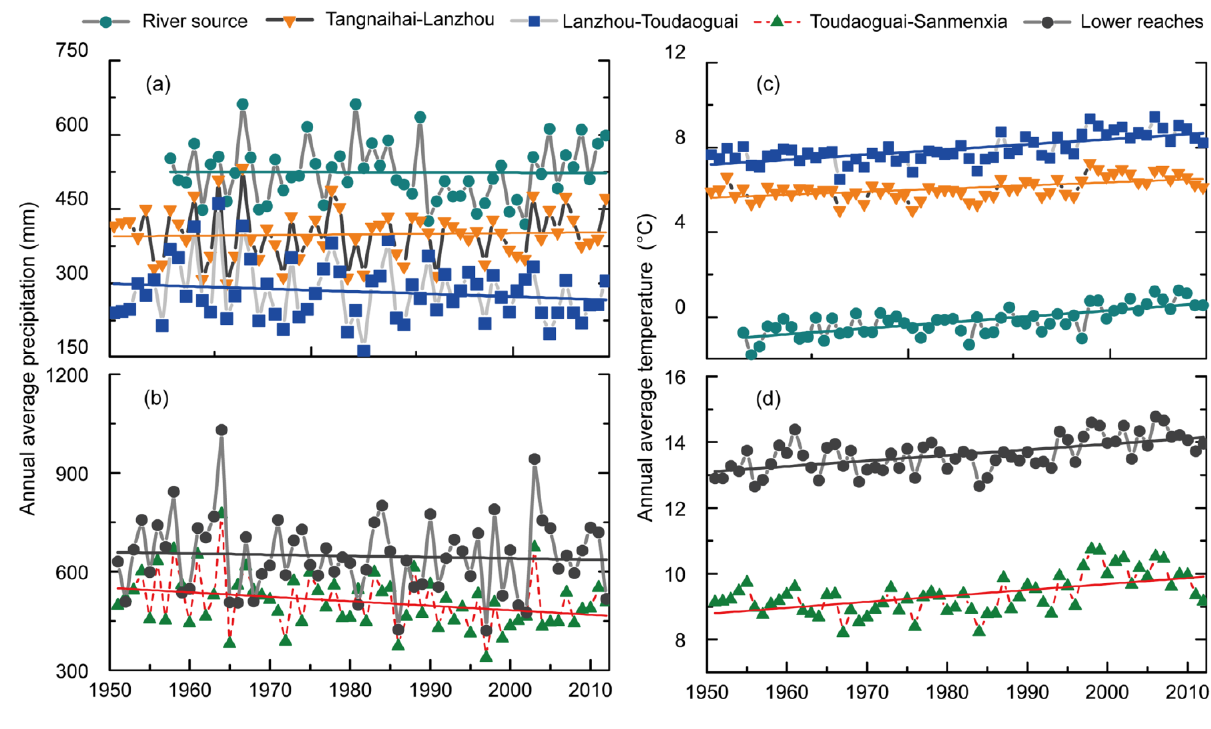
Figure 8. Plots and trend lines of the annual average precipitation and temperature in the Yellow River Basin from the 1950s to 2012. ( a ) Variation of annual precipitation and ( c ) temperature in the river source, Tangnaihai-Lanzhou and Lanzhou-Toudaoguai regions; ( b ) variation of annual precipitation and ( d ) temperature in Toudaoguai-Sanmenxia and Lower reaches